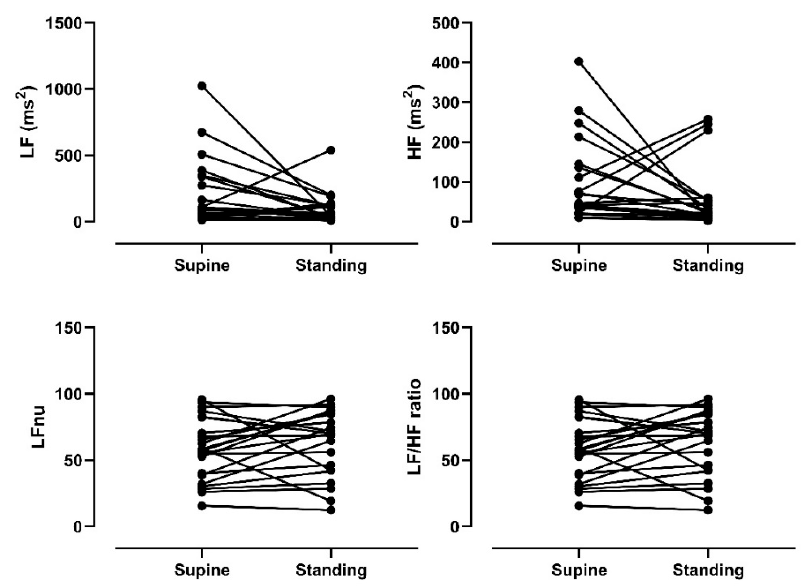
Figure 1. Time domain heart rate variability indices assessed at supine and standing postures. HR: heart rate. SDNN: standard deviation of normal-to-normal RR intervals. RMSSD: root mean square of successive differences in RR interval.